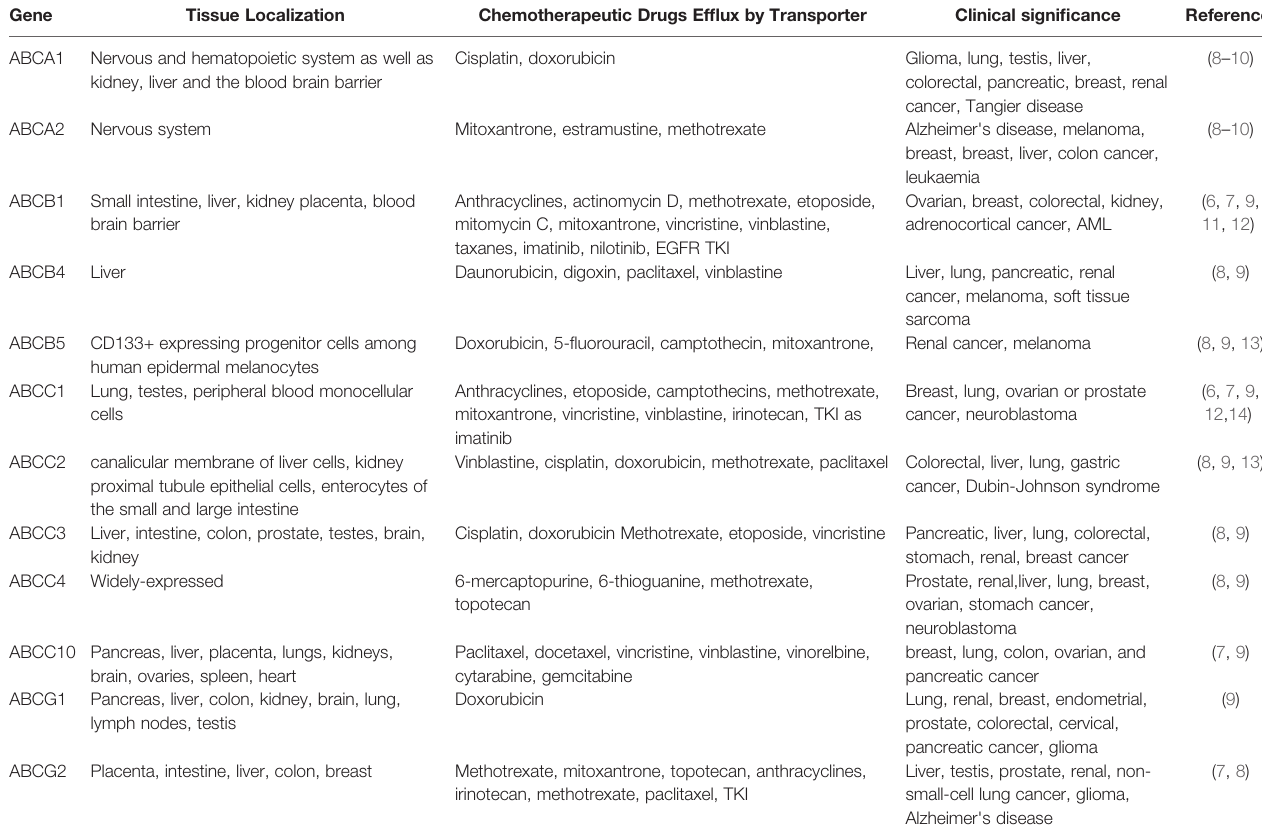
TABLE 1 | ABC transporters and